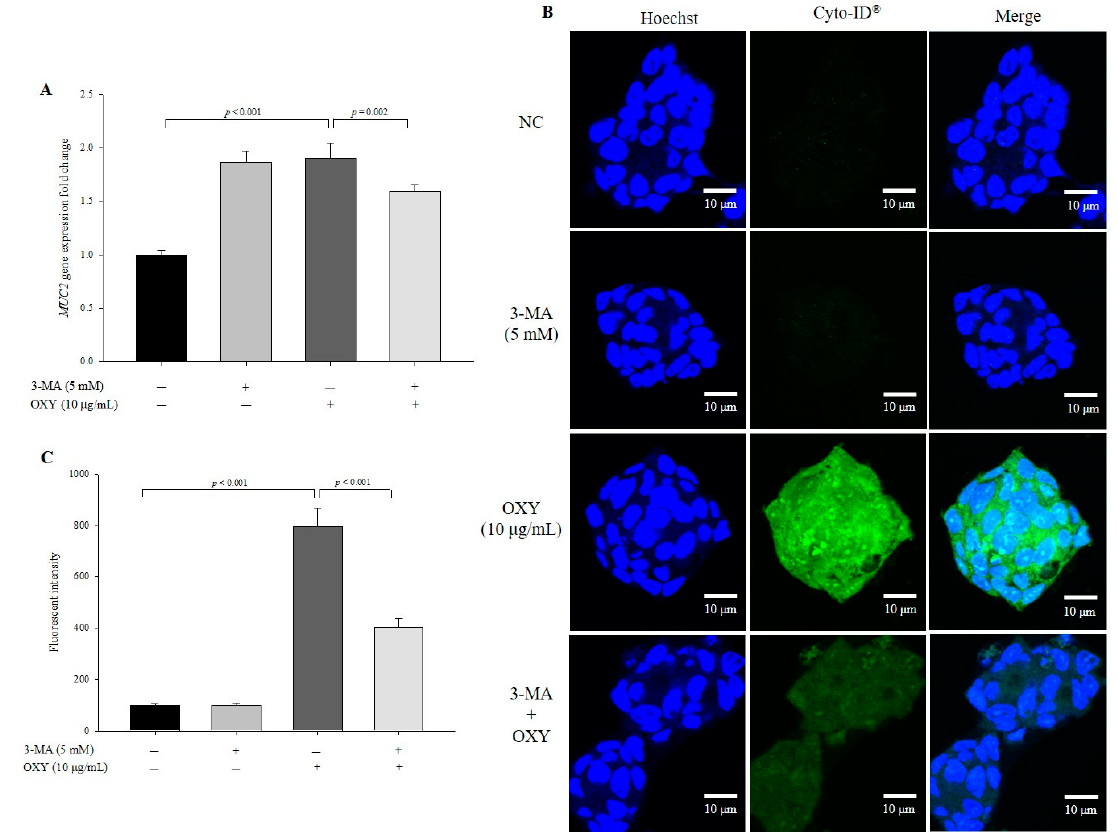
Figure 9. Effect of OXY on mRNA and protein expression of MUC2. Cells were treated with OXY (10 µg/mL) with or without the autophagy inhibitor 3-MA. The expression level of MUC2 was measured by qPCR ( A ). The expression level of the MUC2 protein was determined by ICC ( B ) and quantified ( C ). Each value indicates the mean ± SD of three independent experiments performed in triplicate.